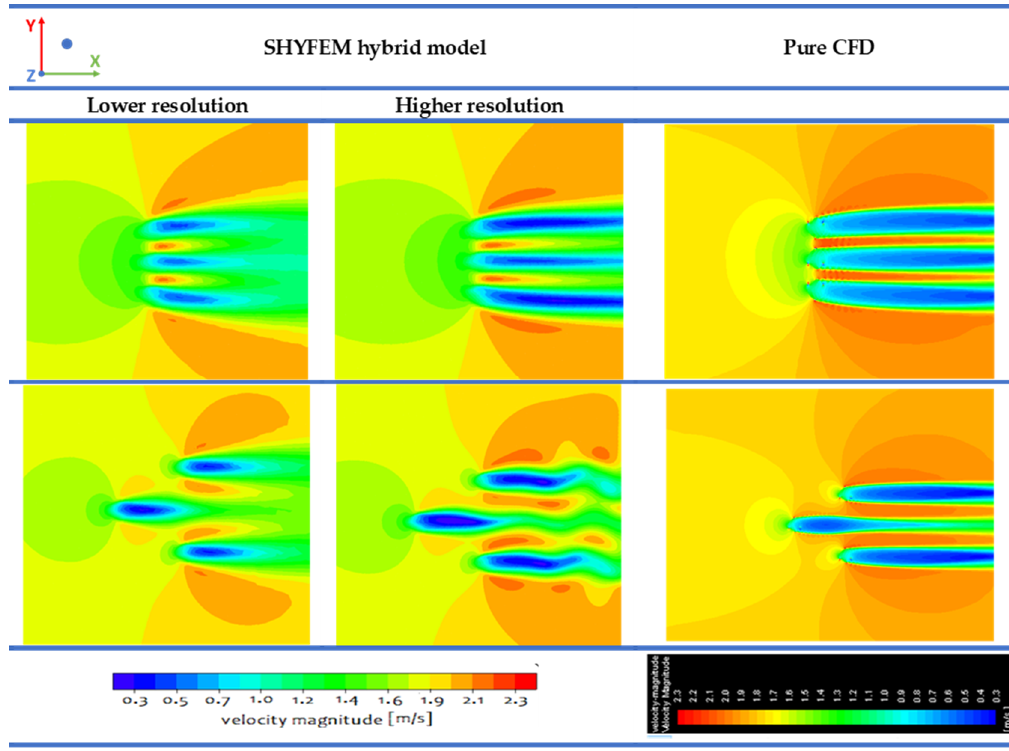
Figure 16. Flow field comparison between the SHYFEM hybrid model, at two different grid resolutions, and pure CFD (top view).